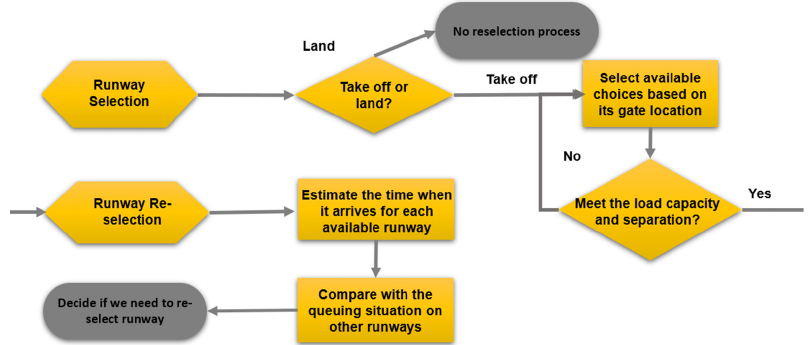
Figure 7. Runway decider workflow.